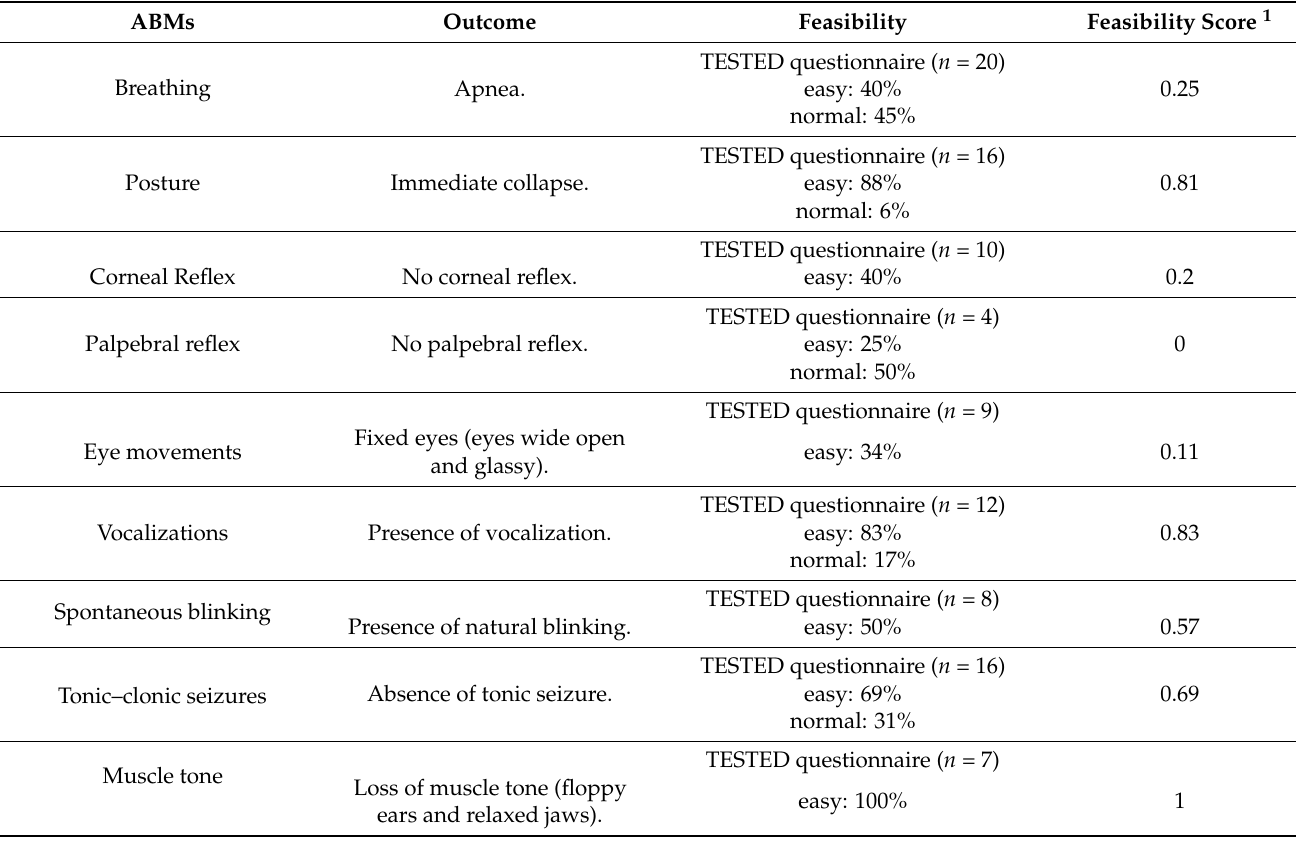
Table 2. Feasibility of ABMs in head-only electrical stunning of sheep. Table based on data from the questionnaire of expert opinions of the EFSA AHAW Panel (2013)